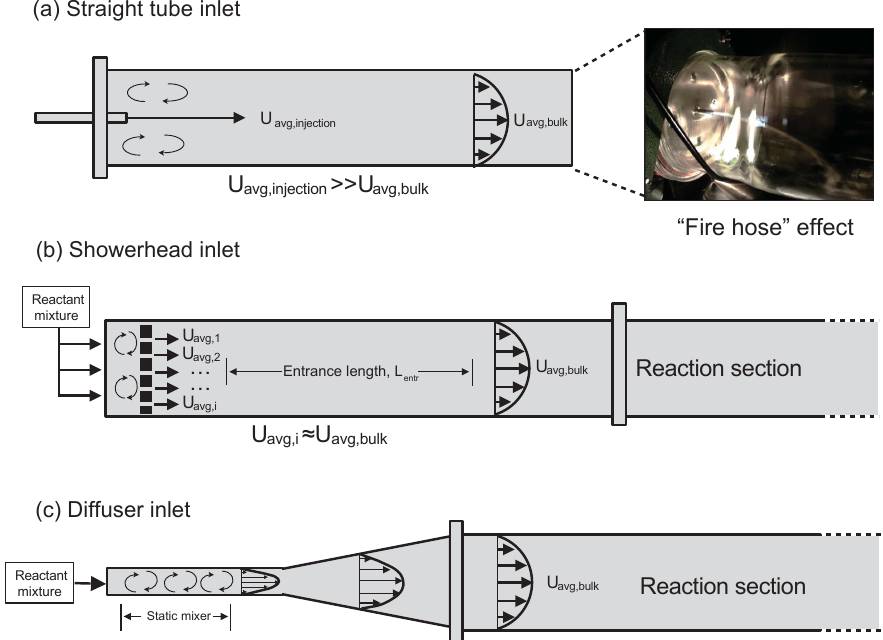
Figure 4. Inlet designs exemplified by (a) straight tube injection, (b) showerhead injection and (c) diffuser injection. U avg,injection , U avg,bulk and U avg,i values denote the average velocities at the inlet, in the bulk reaction section and at the exit of a showerhead hole, respectively. Panel (a) also illustrates the “fire hose” effect, as demonstrated by the visualization of smoke in a Pyrex glass tube. through diffuser cones at various Re . For further discussion about flow separation within diffusers, see Tavoularis (2005).